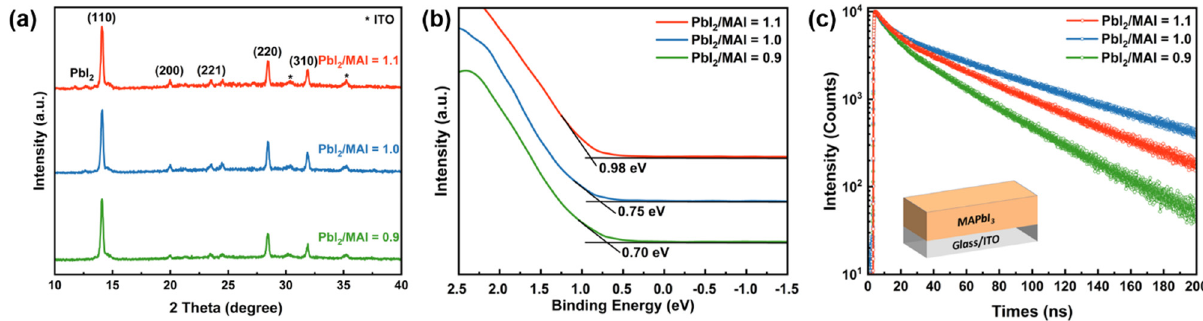
Figure 6. ( a ) X-ray diffraction (XRD) results of perovskite samples with various precursor ratios. “*” refers to ITO. ( b ) X-ray photoelectron spectroscopy (XPS) of MAPbI 3 films under different precursor ratios. ( c ) Time-resolved photoluminescence (TRPL) measurements of the Glass/ITO/MAPbI 3 sample under different precursor